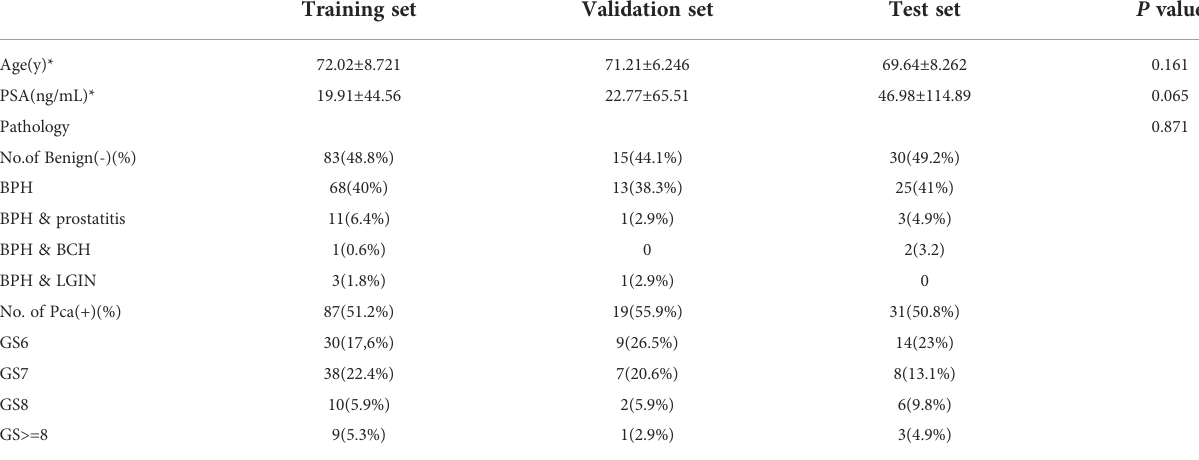
TABLE 1 Characteristics of patients in the training, validation and test datasets.